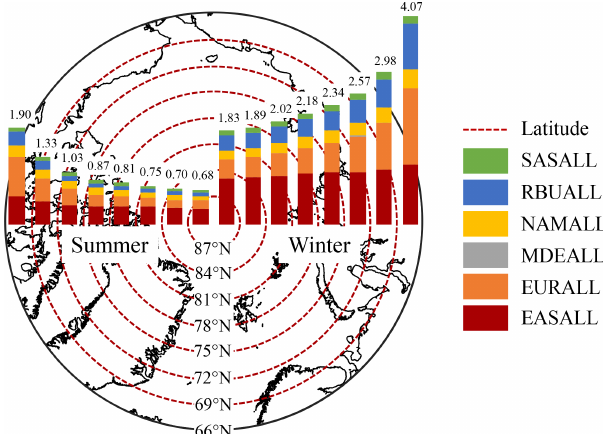
Figure 6. Contributions of 20% emission reductions in different regions to near-surface BC concentrations in each latitudinal band of the Arctic. The results of summer and winter correspond to the left and right panel in the